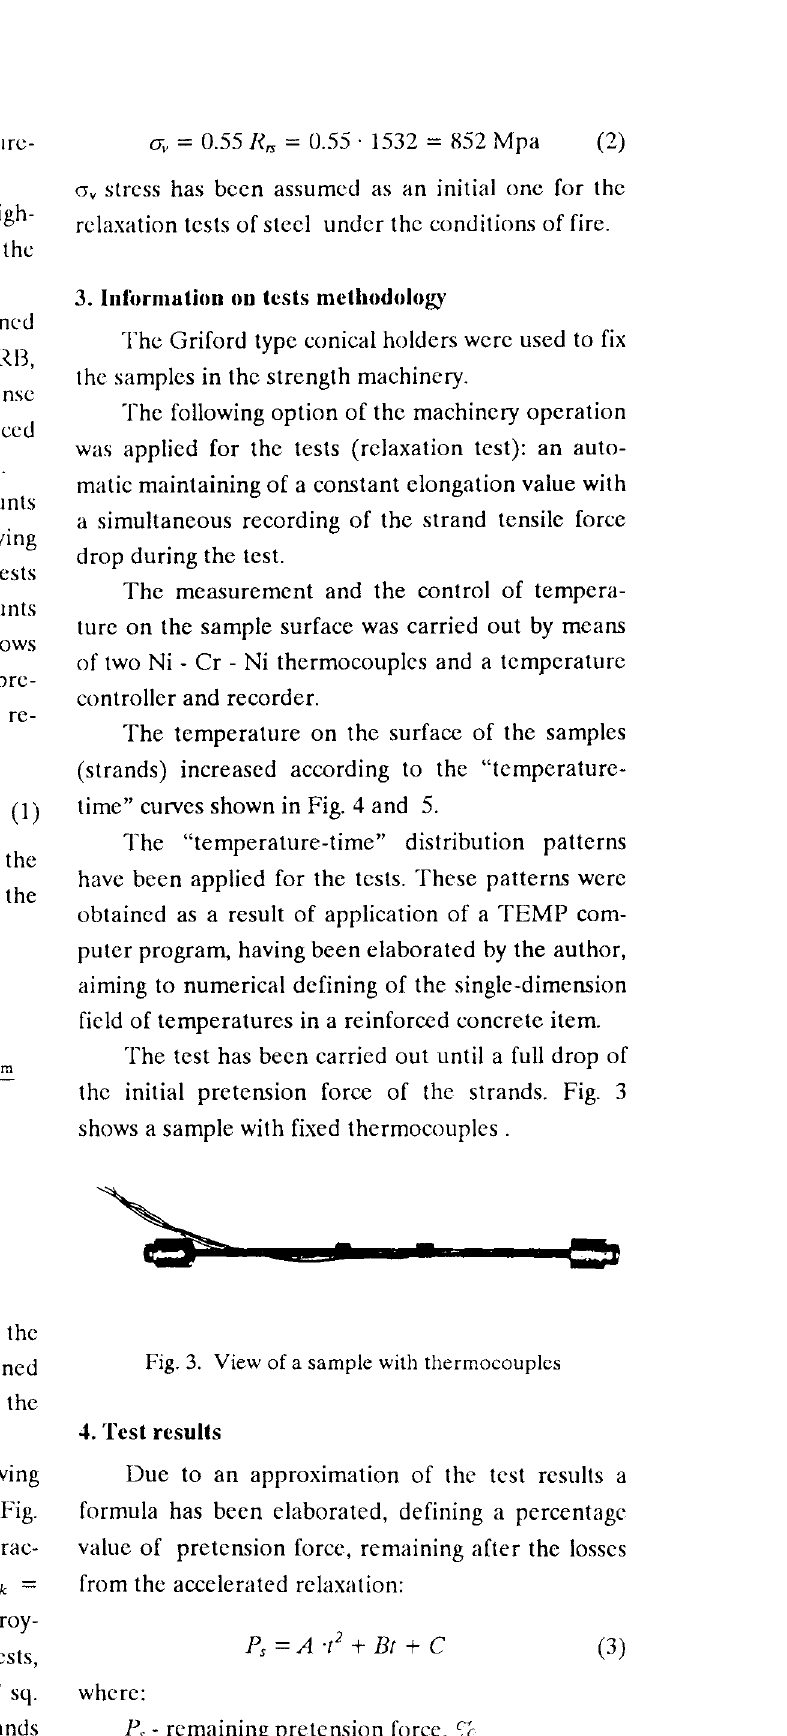
Fig. 3. View of a sample with